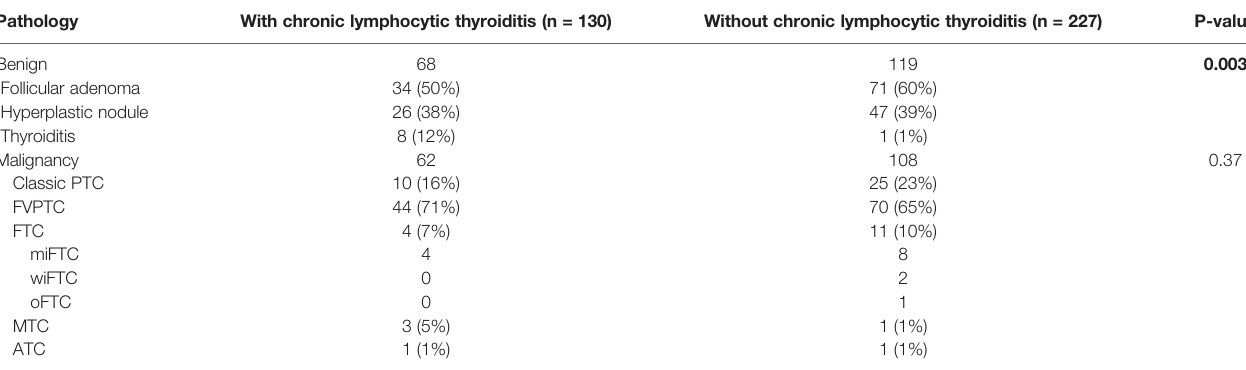
TABLE 2 | Detailed pathology of 357 Bethesda class III thyroid nodules based on the presence of chronic lymphocytic thyroiditis.